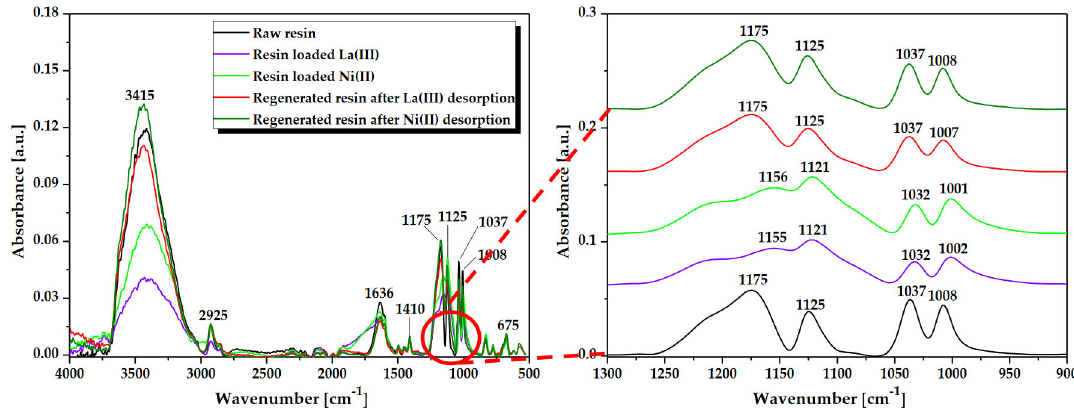
Figure 1. ATR / FT-IR spectra of Lewatit Monoplus SP112 before and after loading with La(III) and Ni(II) ions as well as after